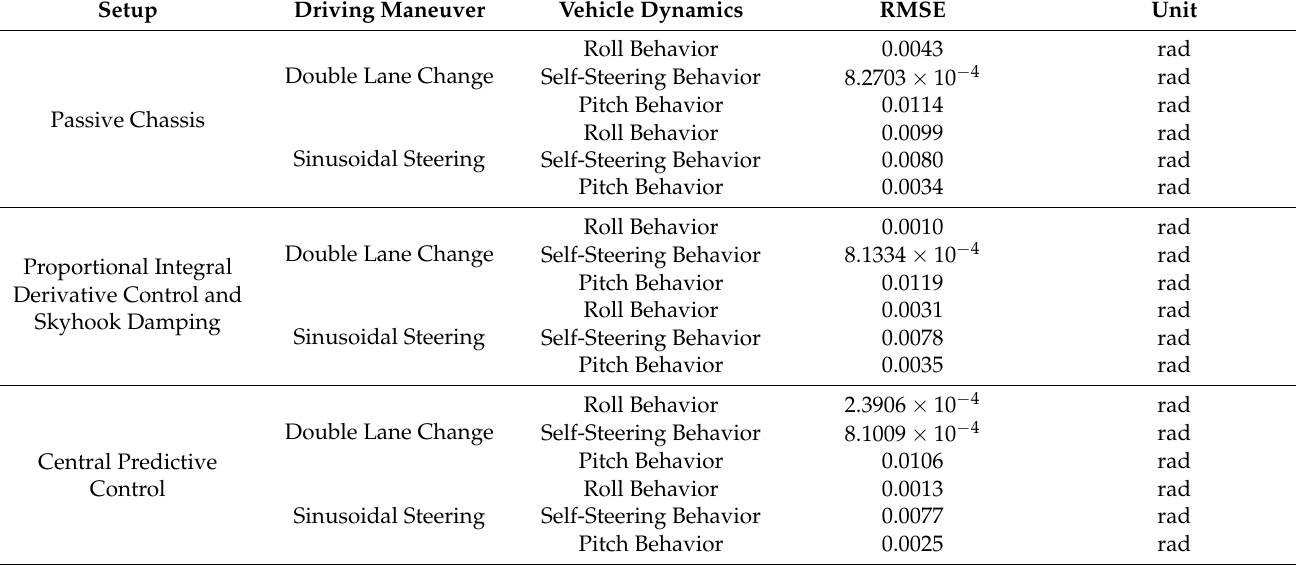
Table 2. Central Predictive Vehicle Dynamics Control—Root Mean Squared